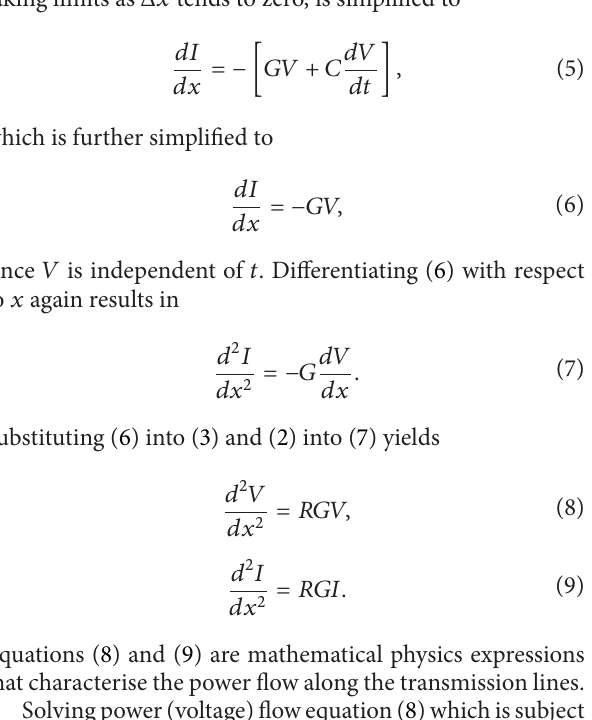
Table1:Currentandvoltagealonga330